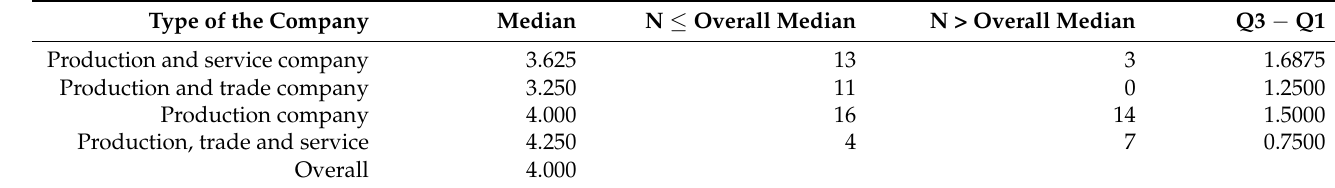
Table 8. Mood’s median test results: digitalization trends vs. type of the company.